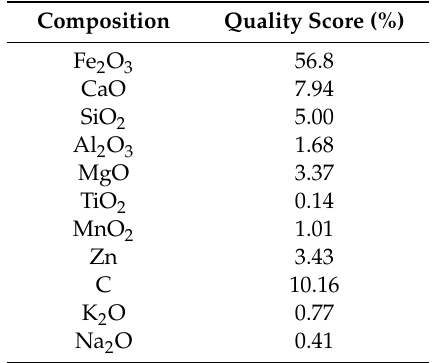
Table 1. Chemical composition of pellets. Table 1 . Chemical composition of pellets.